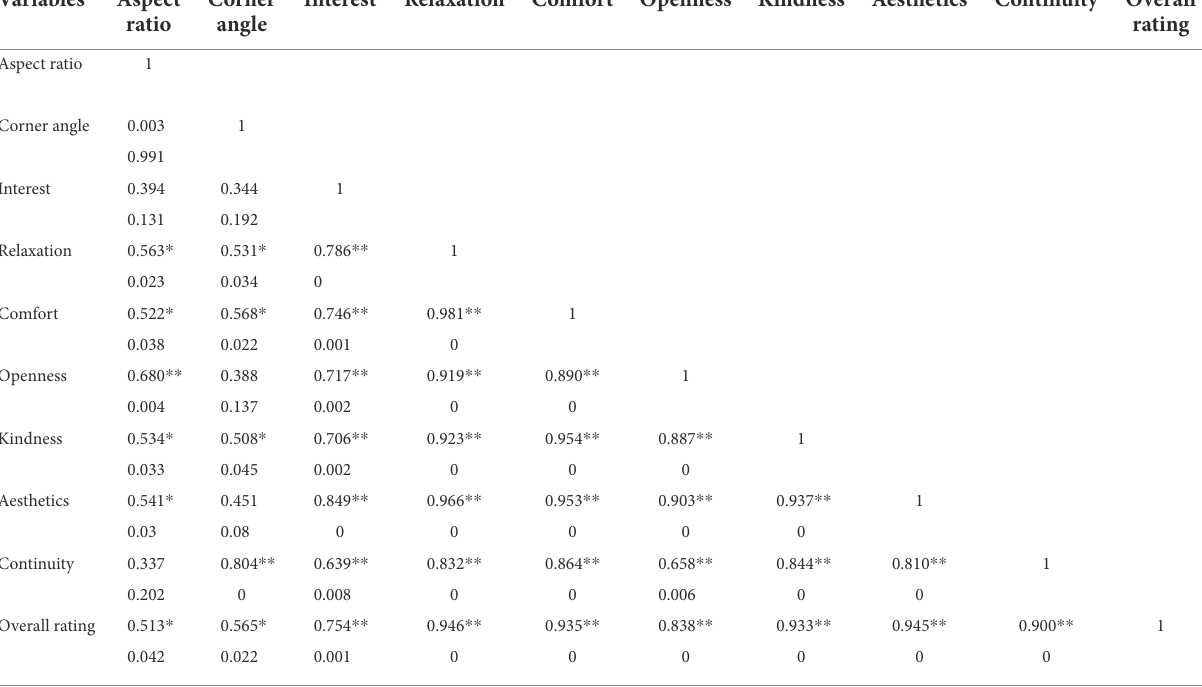
TABLE 8 Correlation analysis of cognitive quantity in each scene